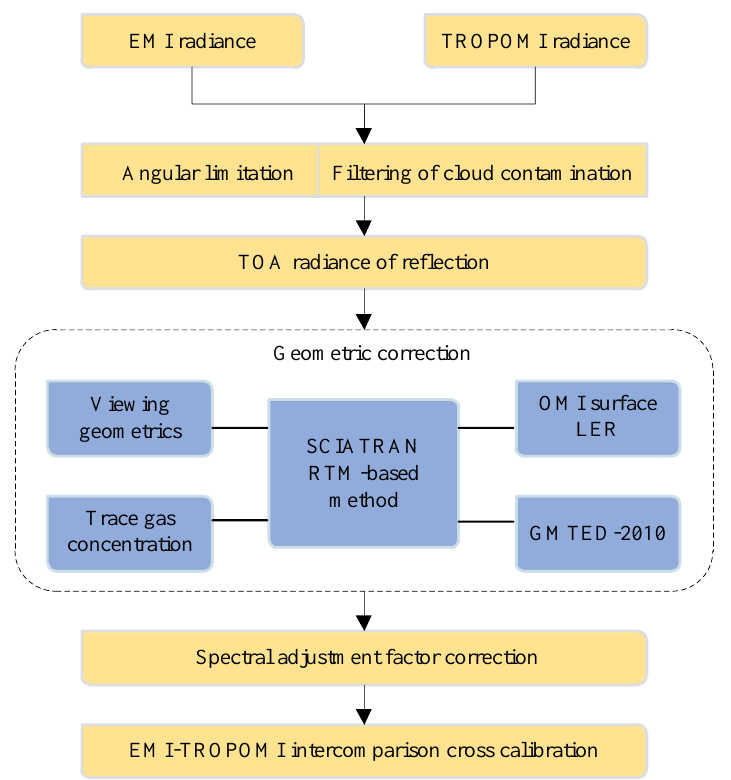
Figure 3. Flowchart for cross-calibration of EMI-2 to TROPOMI based on RTM